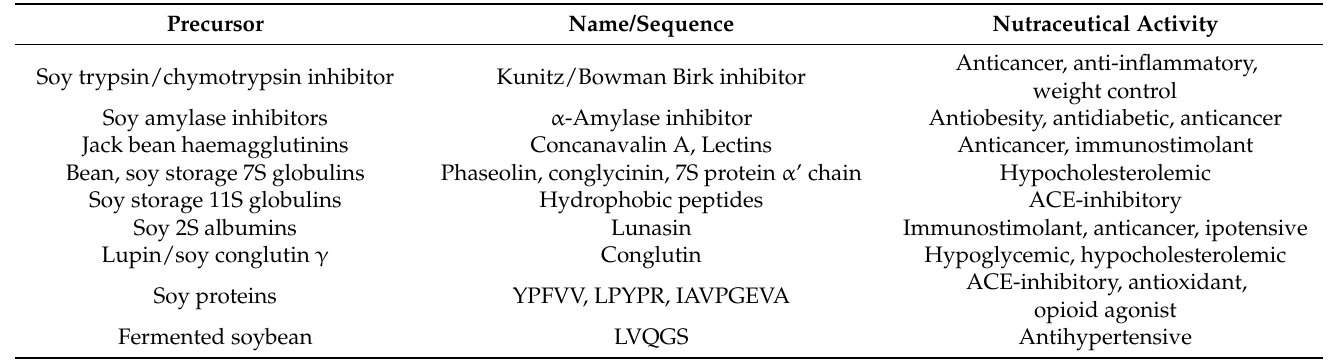
Table 1. Legume proteins and peptides with nutraceutical properties (modified from reference